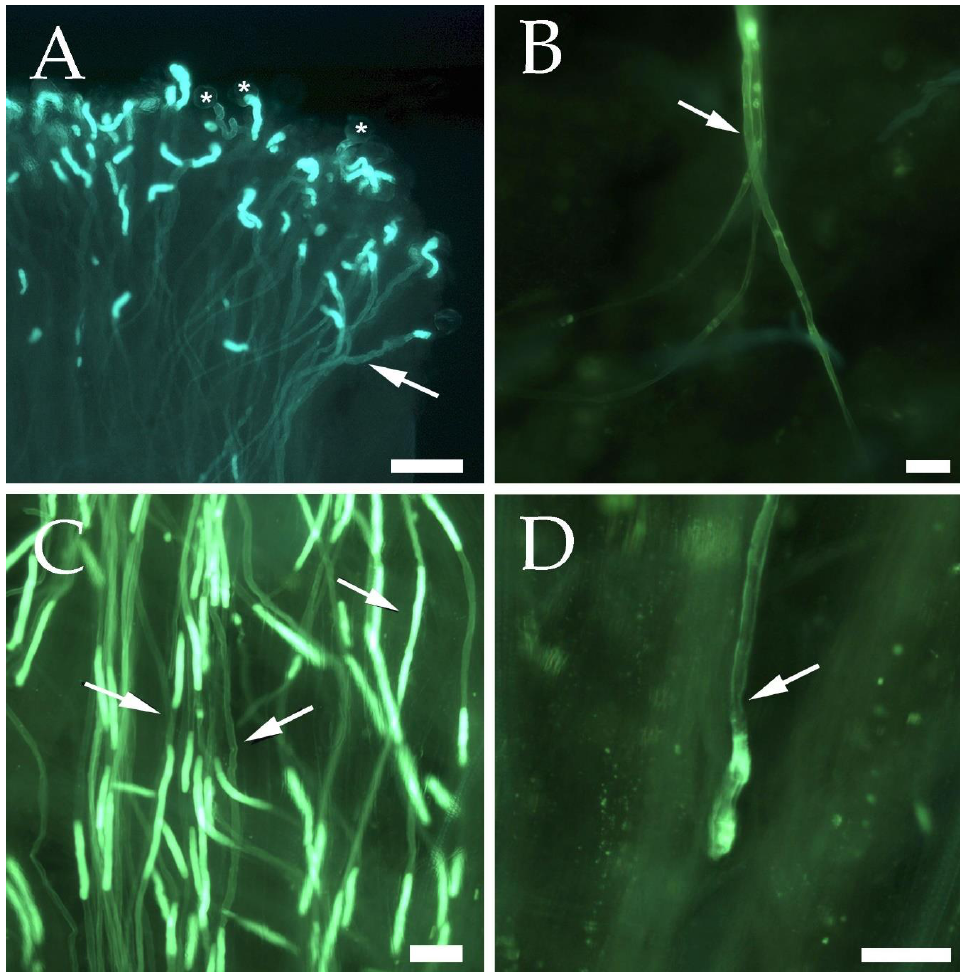
Figure 2. Pollen germination and pollen tube growth in self-pollinated apricot flowers observed under the microscope. In Gametophytic Self-Incompatibility (GSI), both compatible and incompatible pollen grains germinate on the stigma. The pollen grain carries one of the two S -alleles of the original genotype. In self-incompatible cultivars, if the S -allele of the pollen grain matches one of the two S -alleles of the pistil, pollen tube growth is inhibited in the middle part of the style. ( A ) Pollen grains (*) germinating at the stigma surface with pollen tubes emerging towards the style (arrow) in the self-compatible cultivar ‘ Water ’ . ( B ) Pollen tubes (arrow) reaching the base of the style (down) in the self-compatible cultivar ‘ Water ’ . ( C ) Pollen tubes (arrows) growing along the style in the self-compatible cultivar ‘ Water ’ . ( D ) Pollen tube (arrow) arrested in the middle part of the style in the self-incompatible cultivar ’ Samourai ’ . Aniline blue staining for callose of squash preparations. Scale bars = 100 µm.